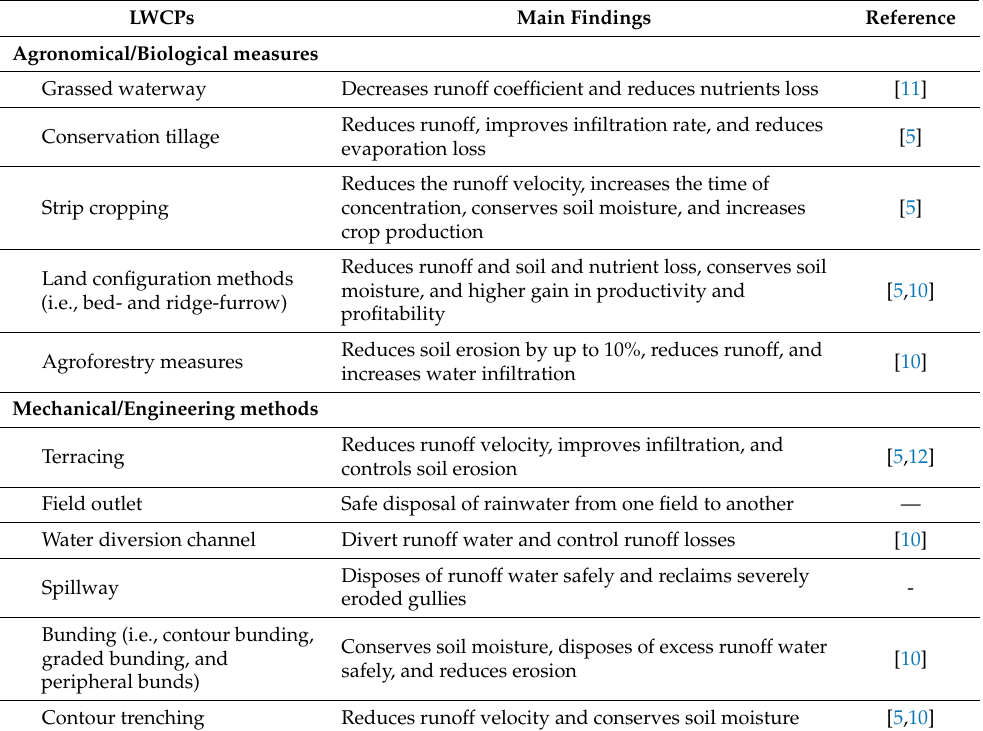
Table 1. Some findings from the literature regarding land and water conservation